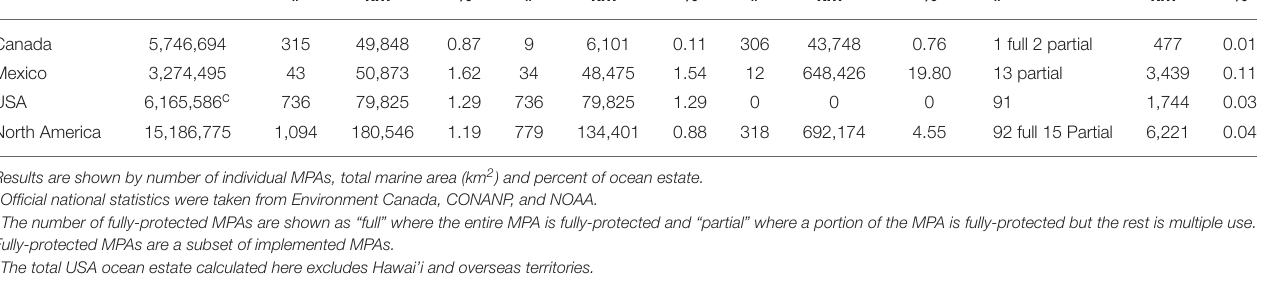
TABLE 1 | Comparison of official national statistics of Canada, Mexico, and USA with implemented, incompletely implemented and fully-protected MPAs identified in this analysis. Country Total ocean All MPAs counted in estate (km 2 ) national statistics